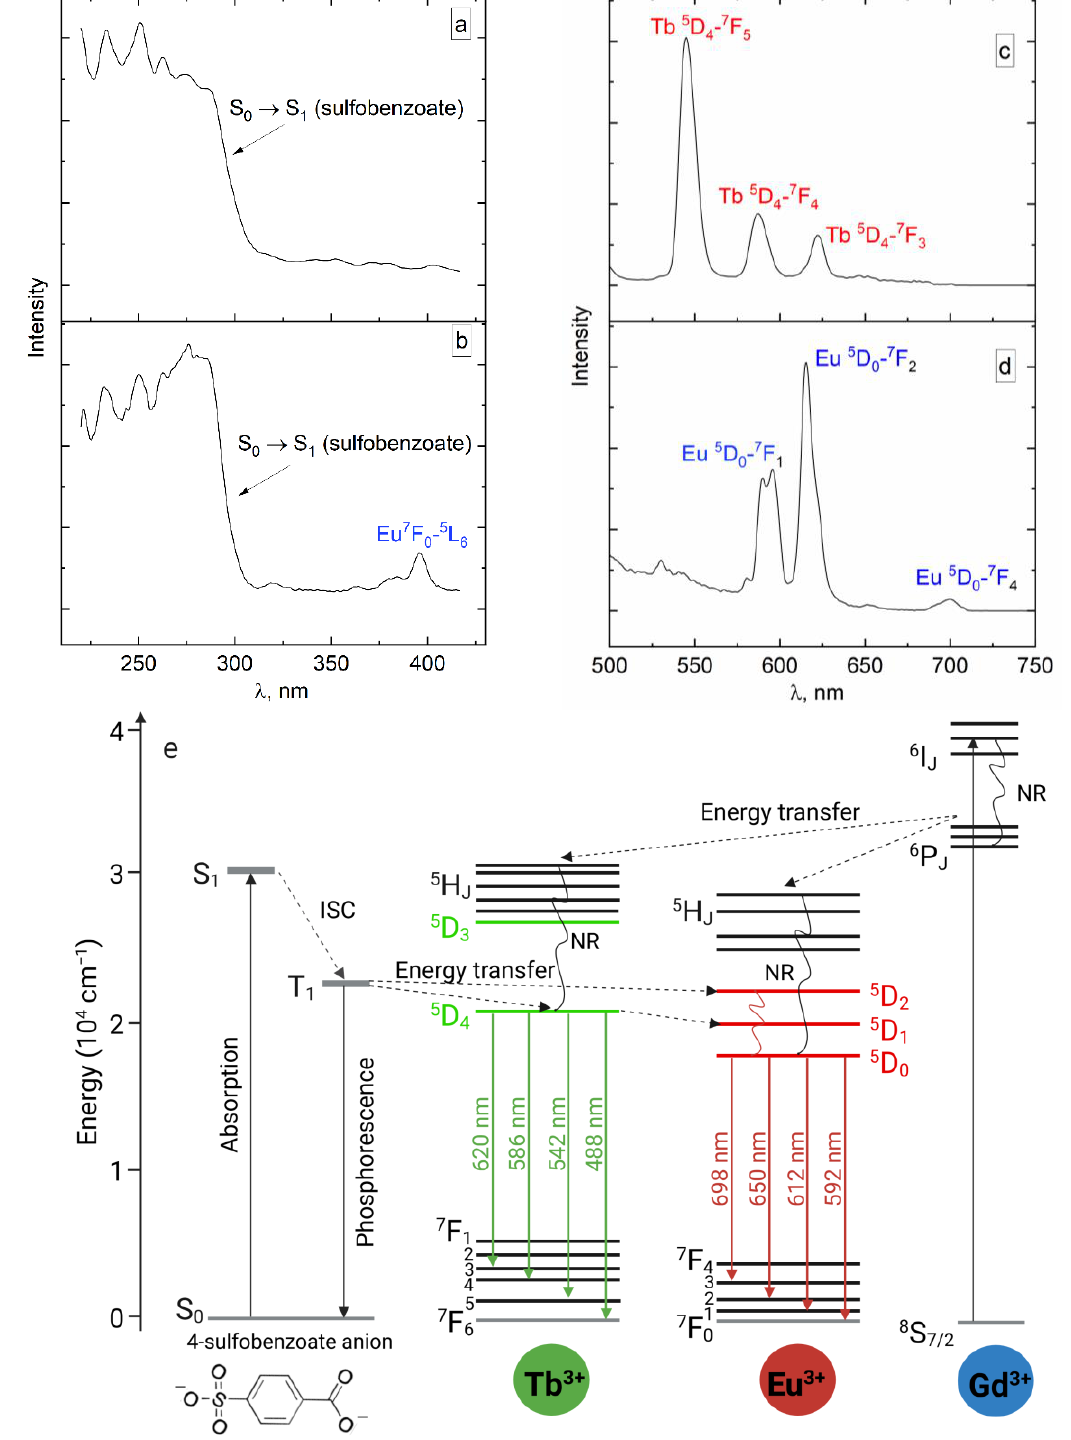
Figure 6. Excitation ( a , b ) and emission ( c , d ) spectra of anion exchange products of terbium ( a , c ) and europium LRH ( b , d ) with potassium sulfobenzoate. ( e ) Energy level diagram showing the possible energy transfer mechanisms between Eu 3+ , Tb 3+ , Gd 3+ , and sulfobenzoate ions in layered rare earth hydroxides. In the diagram, ISC is an intersystem crossing and NR is a nonradiative transition. To establish the composition ranges of ternary layered Gd-Eu-Tb basic sulfobenzo- ates (Gd 1 − x − y Tb x Eu y ) 3 (OH) 7 (C 7 H 4 O 5 S)· n H 2 O in which the Tb 3+ → Eu 3+ energy transfer (Figure 6e) [46,62,63] takes place, the absolute intensity ratio µ = I Eu /( I Eu + I Tb ) was calculated, where